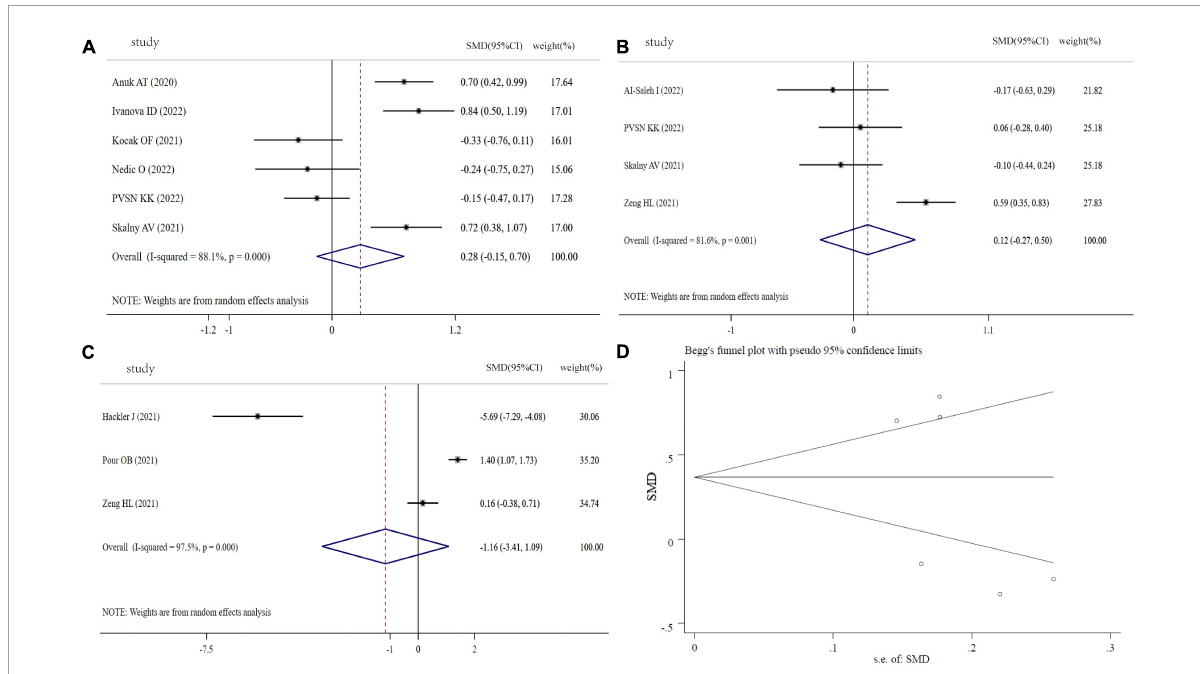
FIGURE4 Forest plot of Cu levels. (A) Cu levels between COVID-19 patients and controls; (B) Cu levels between severity status and non-severity status in COVID-19 patients; (C) Cu levels between non-survivors and survivors in COVID-19 patients; (D) funnel plot of the meta-analysis on Cu levels between COVID-19 patients and